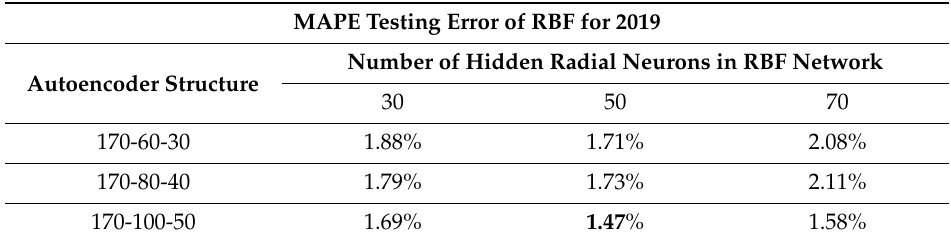
Table 3. Mean MAPE errors for all the weeks of 2019, using the RBF network as a predictor.